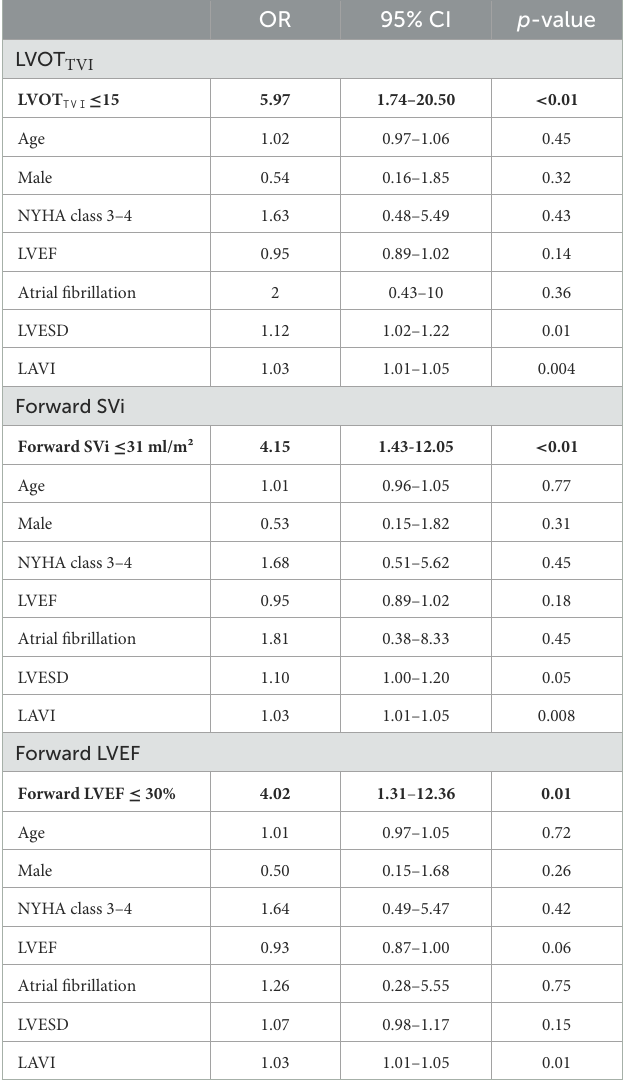
TABLE 6 Multivariable risk factor analysis for predicting post-operative LV systolic dysfunction in 198 patients subject to mitral valve repair for severe DMR using cutoff values for LVOT TVI , SVi and forward LVEF defined by ROC curve